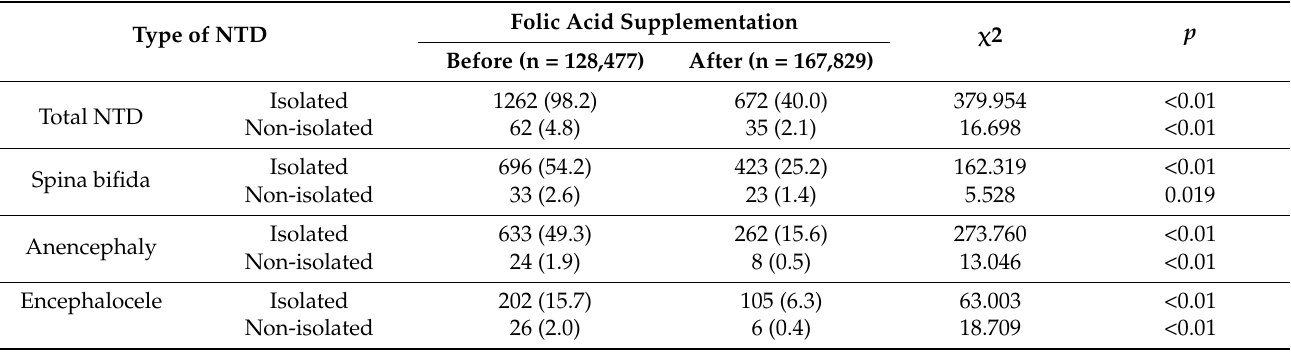
Table 3. Prevalence of isolated and non-isolated NTDs before and after national folic acid supple- mentation in five counties in Shanxi province of Northern China, 2002–2021, N